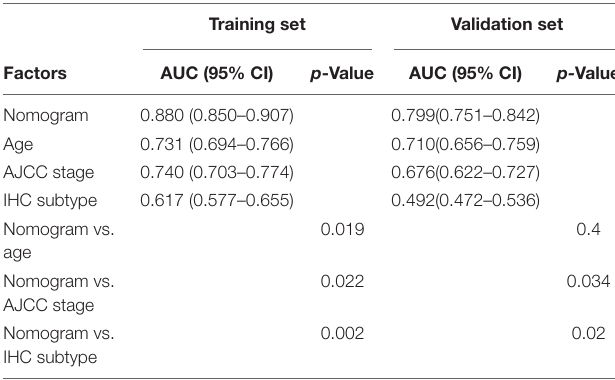
TABLE 3 | The AUC of nomogram, age, AJCC stage, and IHC subtype for prediction of OS in the training set and validation set. Training